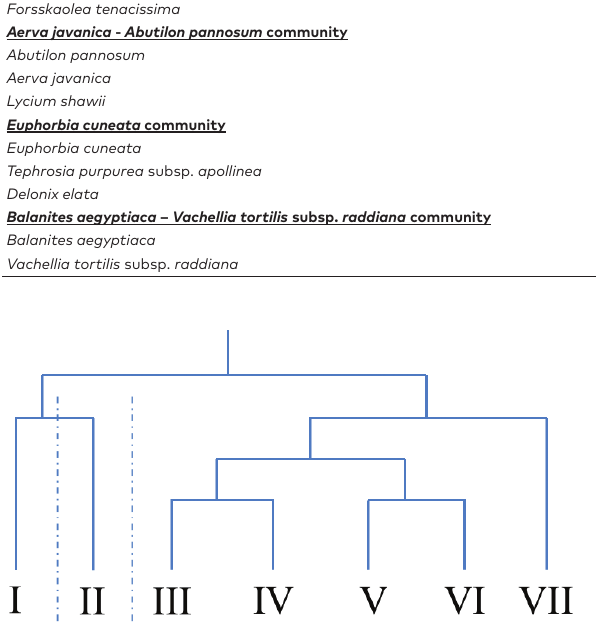
Vachellia tortilis subsp. tortilis